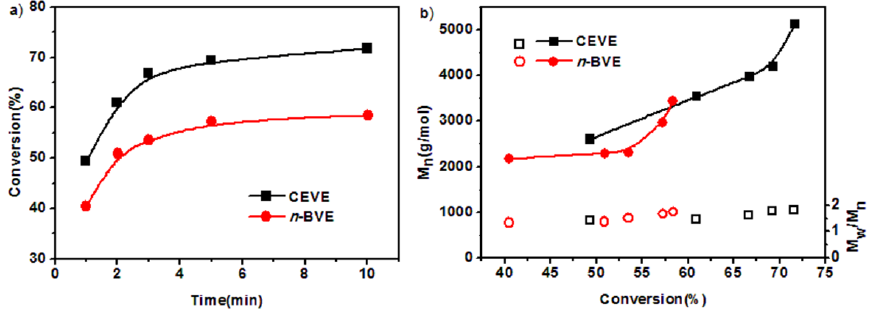
Figure 5. Cationic polymerization of CEVE and n -BVE initiated by CumOH/B(C 6 F 5 ) 3 /Et 2 O in H 2 O at 20 ◦ C: ( a ) conversion vs time; ( b ) Mn and Mw/Mn vs conversion; [CEVE] = 2.0 M; [ n -BVE] = 1.6 M; [CumOH] = [B(C 6 F 5 ) 3 ] = 0.05 M; [Et 2 O] = 0.1